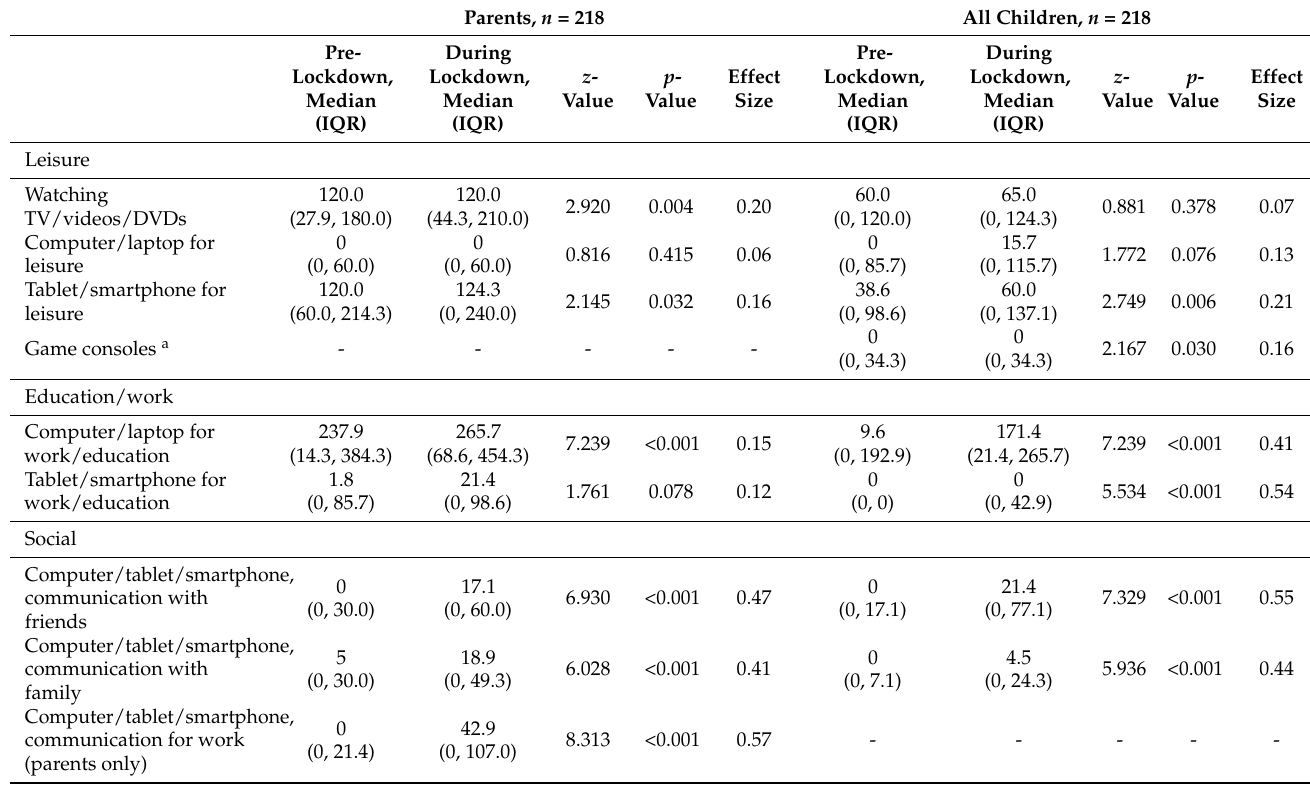
Table 2. Duration (median minutes per day, IQR) that parents and children engaged in screen time behaviours